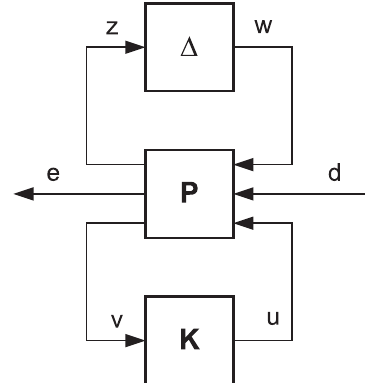
Figure 5. The generalized closed-loop system configuration with